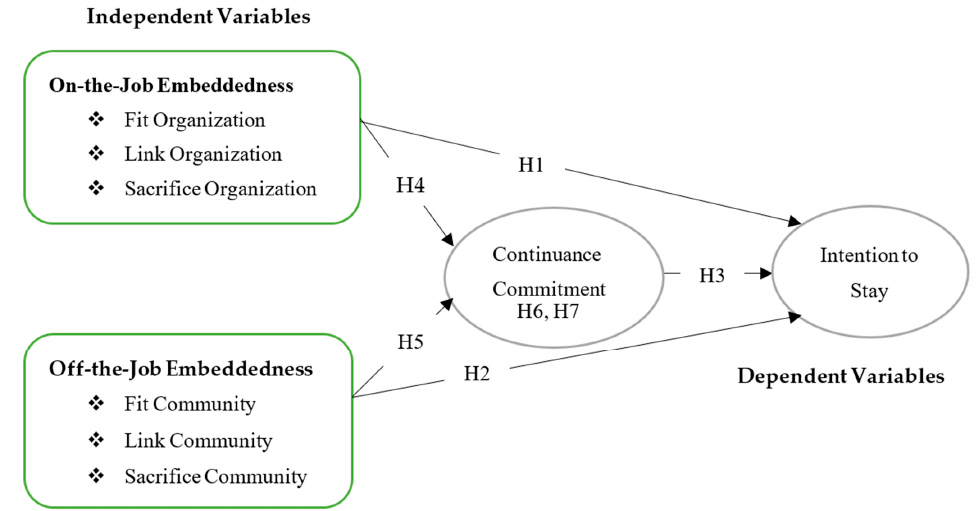
Figure 1. Conceptual Framework.